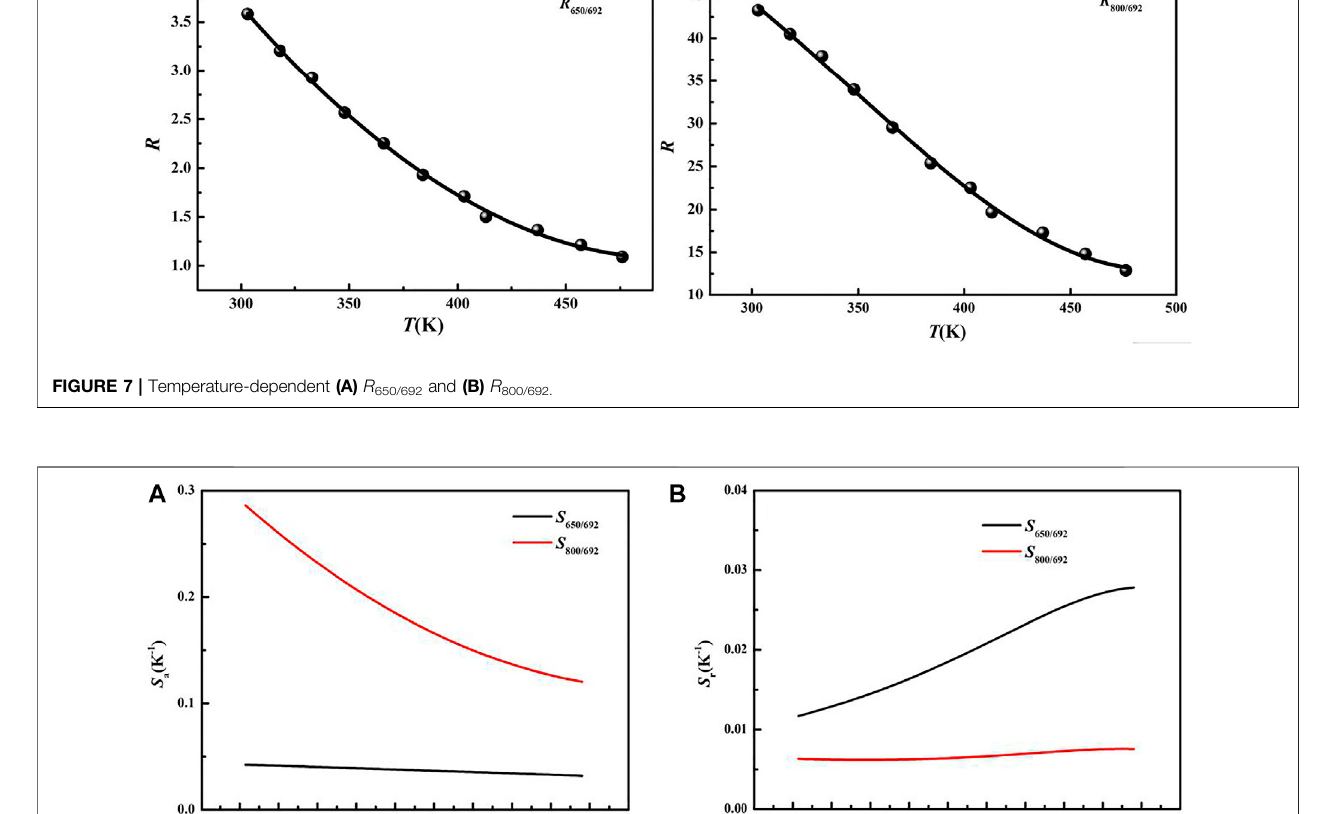
Frontiers in Materials |